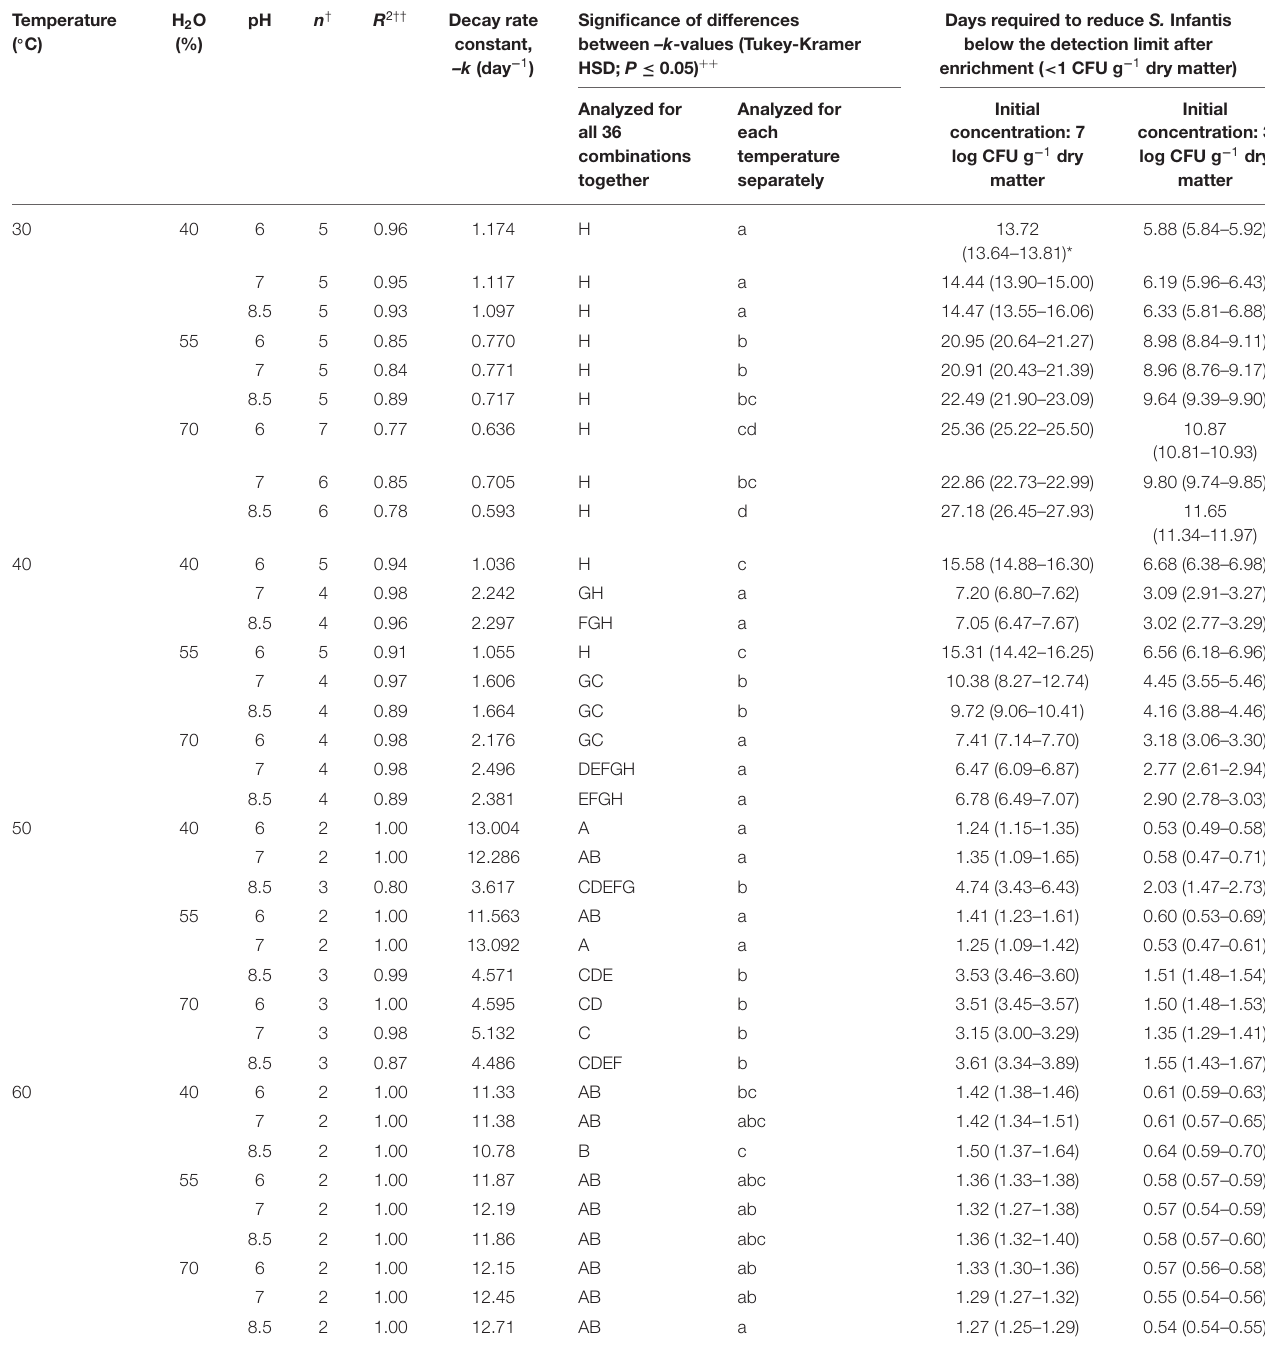
TABLE 2 | First-order decay rate constants ( –k; day − 1 ) and the calculated time needed to reduce S. Infantis below the detection limit after enrichment, at initial concentrations of 7 and 3 log CFU g − 1 dry matter. Temperature ( ◦